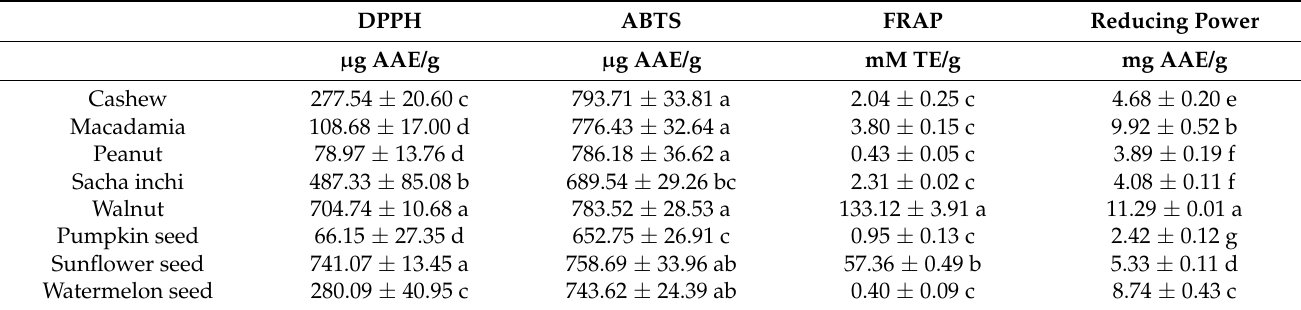
Table 5. Antioxidant activity ( µ g AAE/g or mM TE/g FW) of the studied nuts and seeds. DPPH ABTS FRAP Reducing